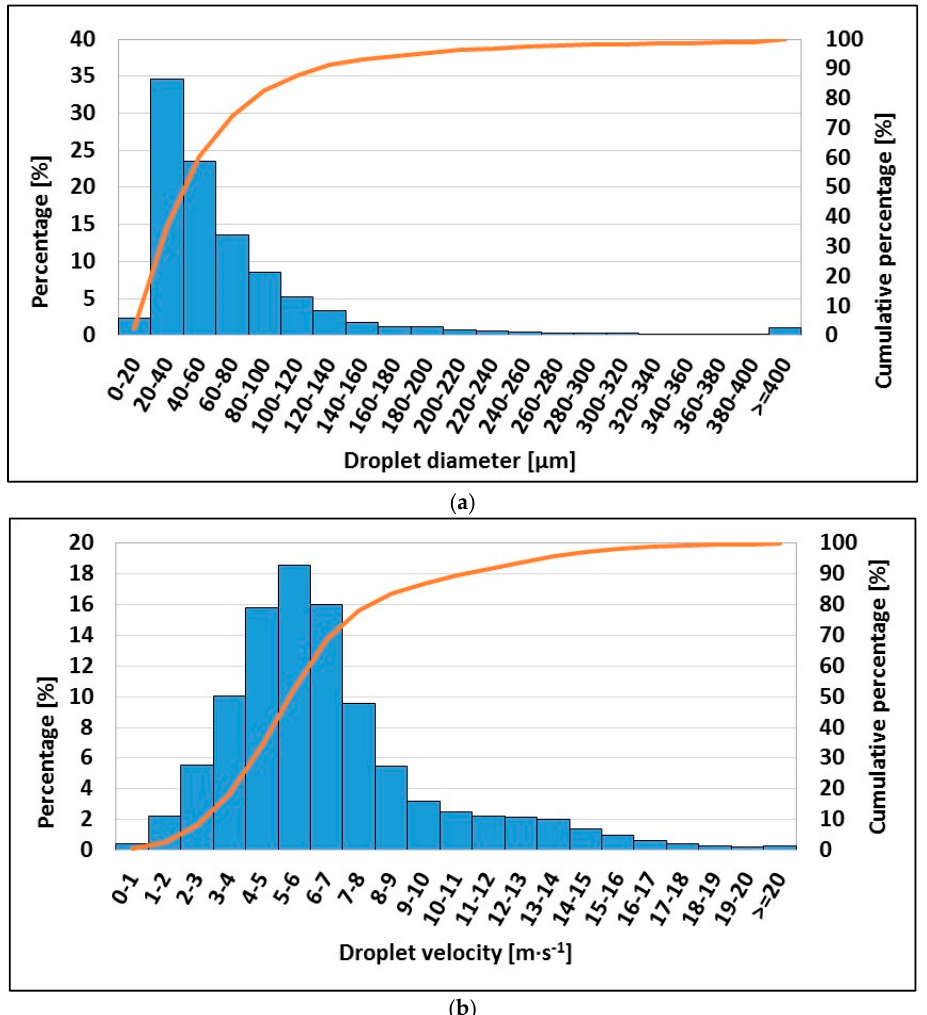
Figure 11. Droplet diameter ( a ) and droplet velocity ( b ) scatter plotted for E5 nozzle in position